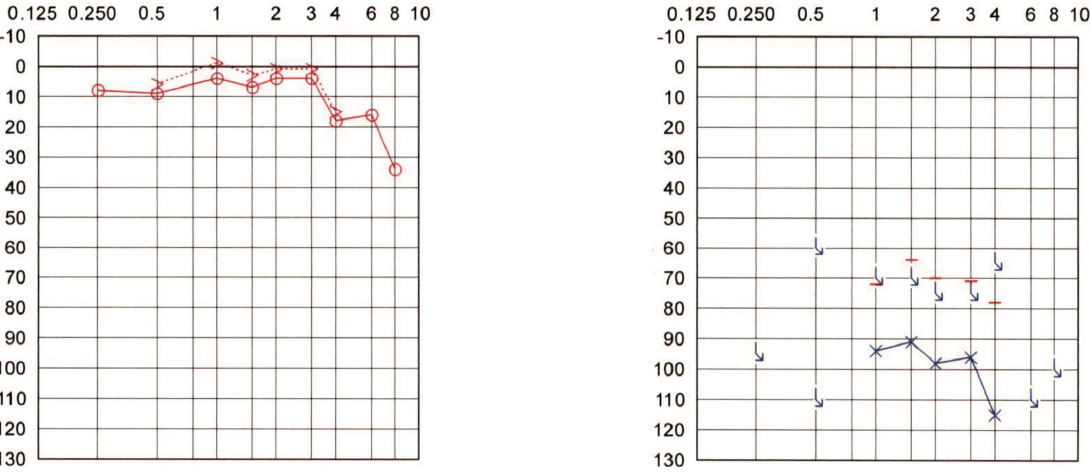
Figure 5. Pure tone audiogram of Patient #9 with left-sided profound hearing loss since birth. Patient #10 is a 52-year-old man with left-sided Meni è re’s disease for over twenty years. The disease progression had resulted in recurrent vertigo attacks, left-sided sen- sorineural hearing loss, and tinnitus. After multiple intratympanic gentamicin injections, complete control of the vertigo attacks was reached. However, the intratympanic gen- tamicin treatment resulted in a left-sided profound UHL for over 18 years. The Weber test lateralized to the contralateral (right) side. The patient was referred to the cochlear implantation unit for auditory rehabilitation. The PTA is shown in Figure